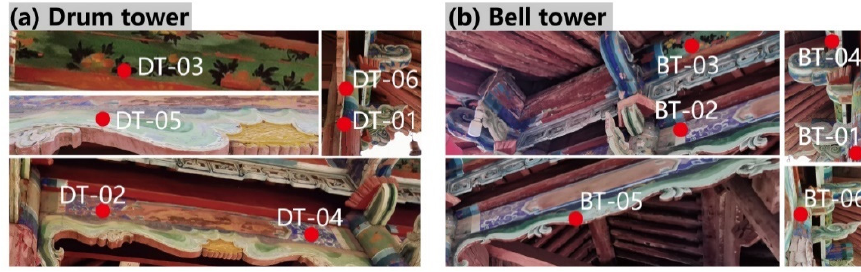
Figure 2. The Sampling position: ( a ) the Drum tower; ( b ) the Bell tower.